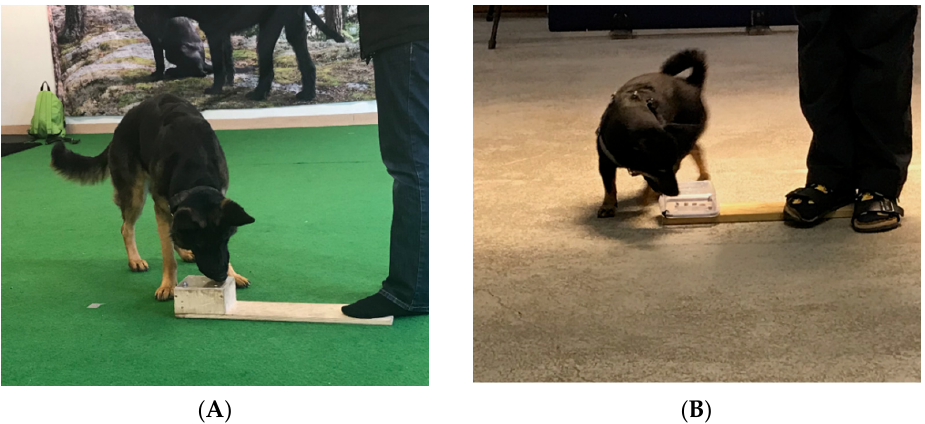
Figure 2. Test setup for the unsolvable task. Images are from the test phase, when the lid is fully closed, and the box is impossible to open. ( A ) Wooden box used for large dogs. ( B ) Plastic box used for small dogs.